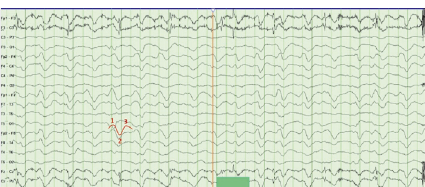
Figure 2: Continuous electroencephalography (CEEG). CEEG shows generalized slowing with triphasic waves. The three phases of the wave that give the classic triphasic morphology are highlighted. Intracranial pressure at the time of this CEEG was